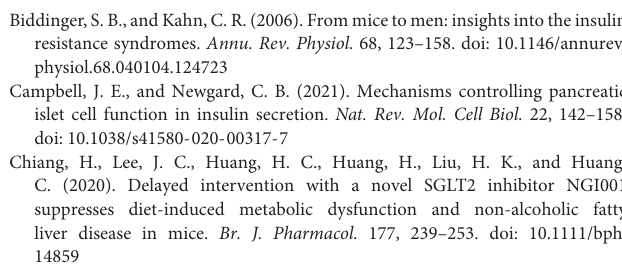
Supplementary Figure 2 | Effects of different concentrations of empagliflozin and PA in HL7702 cells. (A,B) Relative mRNA expression levels of PEPCK and G6PASE in HL7702 cells treated with different concentrations of PA for 24 h ( n = 3 samples/group). (C) The viabilities of HL7702 cells treated with different concentrations of empagliflozin was detected by CCK-8 assay ( n = 3 samples/group). ∗ P < 0.05, 0.75 mmol/L PA vs.